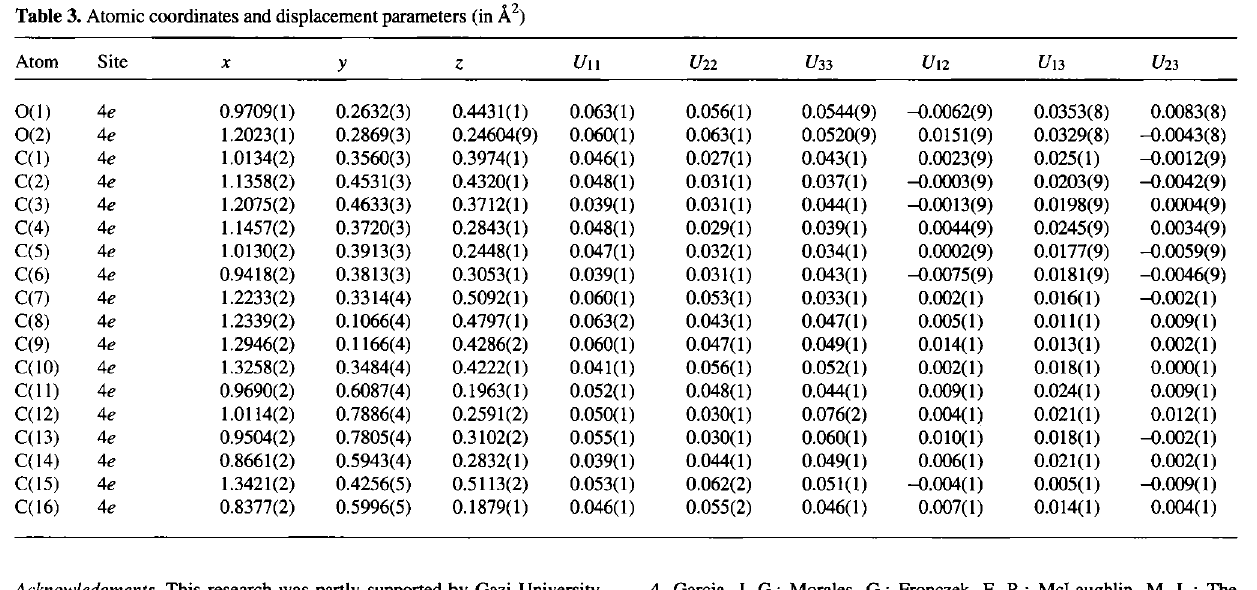
Table 3. Atomic coordinates and displacement parameters (in Â 2